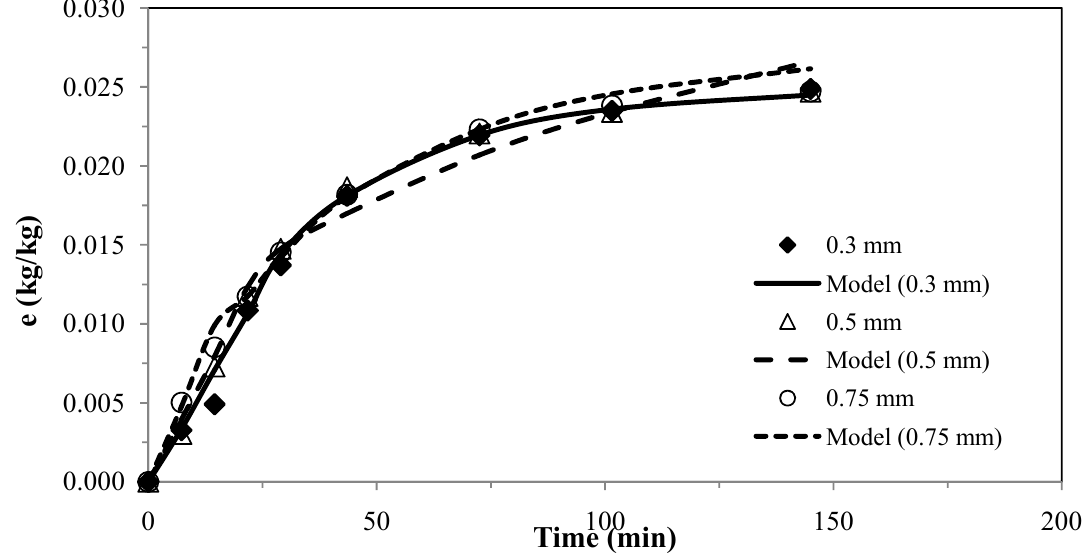
Figure 2. Pennyroyal essential oil yield for different mean particle size and and CO